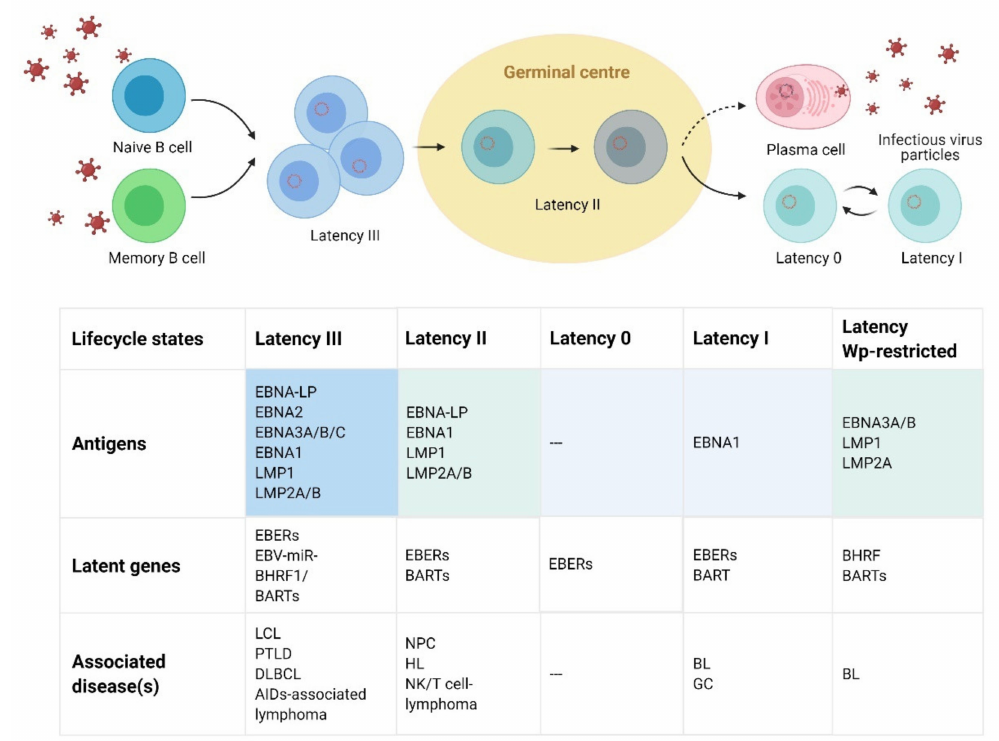
Figure 1. The phases of EBV infection in host cells and antigen expression. EBV in latent infection only expresses a minimal number of latent genes to maintain the stable presence of the virus’ genome in cells and to promote the survival of infected cells while minimizing host immune recognition. According to the protein expression patterns, three latency phases have been identified, and the types and numbers of latent genes expressed by each phase differs. Latency III is the most elaborate viral expression phase (EBERs, EBNA-LP, EBNA1, EBNA2, EBNA3A–3C, LMP1, LPM2A, and LMP2B). It is commonly observed in cells in a highly clonal proliferative state, such as newly infected B cells or EBV-immortalized lymphoblastoid cell lines (LCLs). This phase is associated with the post-transplant lymphoproliferative disorder (PTLD), the spread of large B cell lymphoma (PT-DLBCL) after EBV transplantation, and AIDS-associated diffuse large B cell lymphoma. Latency II is more limited in protein expression (EBERs, EBNA-LP, EBNA1, LMP1, LMP2A, and LMP2B) and is associated with nasopharyngeal carcinoma (NPC), PT-DLBCL, Hodgkin’s lymphoma (HL), and natural killer (NK)/T cell lymphoma. Latency I, the strictest latency phase (EBERs and EBNA1), can be found in proliferating memory B cells and is associated with post-transplant Burkitt lymphoma (BL) and gastric carcinoma (GC). Latency 0 is commonly in resting memory B cells without the expression of viral protein components. Moreover, the Wp-restricted latency phase (EBNA3A/3B, LMP1, and LMP2A) is associated with BL. In addition, non-coding RNA transcription of EBV in the state of latent infection exists. Figure created with